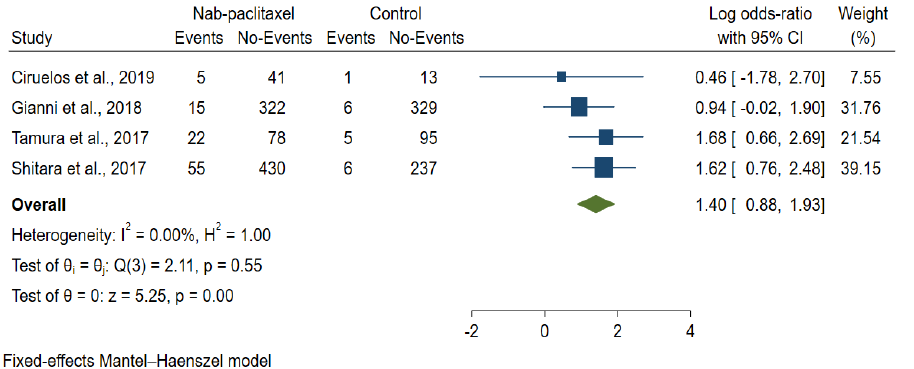
Fig. 6. The forest plot showed the odds ratio of Severe neurotoxicity (Grade